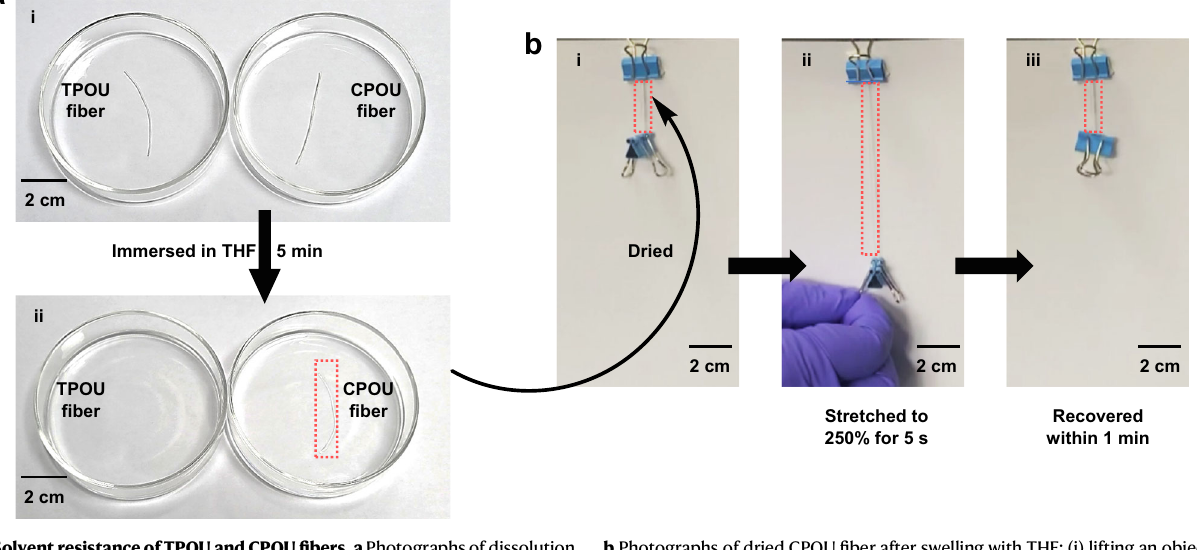
Fig.4|SolventresistanceofTPOUandCPOU fi bers.a Photographsofdissolution tests of TPOU and CPOU fi bers. (i) Fibers were immersed in THF at room tem- perature; (ii) after 5min, TPOU fi ber dissolved, while CPOU fi ber kept intact.